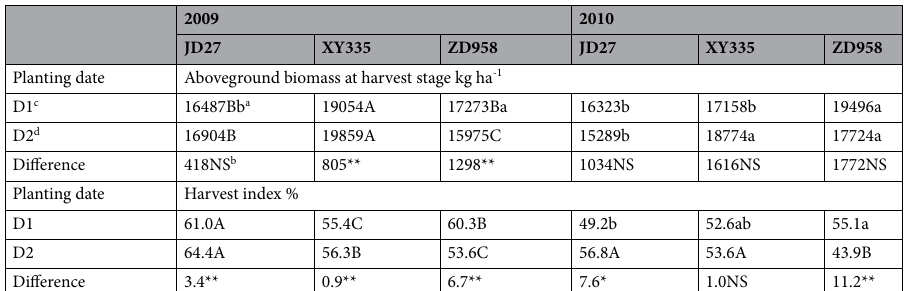
Table 4. Effects of planting date and hybrid maturity on aboveground biomass at harvest stage, and harvest index of dryland corn at Lishu city, Northeast China during 2009 and 2010 growing seasons. a Means within a row followed by a different lower-case letter differ at P < 0.05. Means within a row followed by a different upper-case letter differ at P < 0.01. b NS, not significant. c D1 represents the planting date of maize in early May. The planting dates for 2009 and 2010 were May 2 and May 4, respectively. d D2 represents the planting date of maize in mid-May. The planting dates for 2009 and 2010 were May 12 and May 14, respectively. * Significant at the 0.05 level. ** Significant at the 0.01